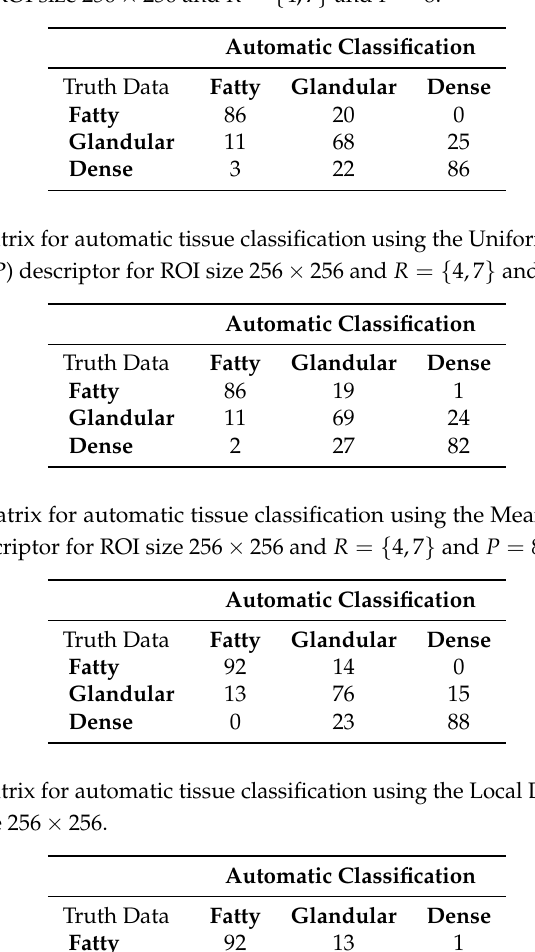
Table 3. Confusion matrix for automatic tissue classification using the Elliptical Local Binary Pattern (ELBP) descriptor for ROI size 256 × 256 and R = { 4,7 } and P = 8.